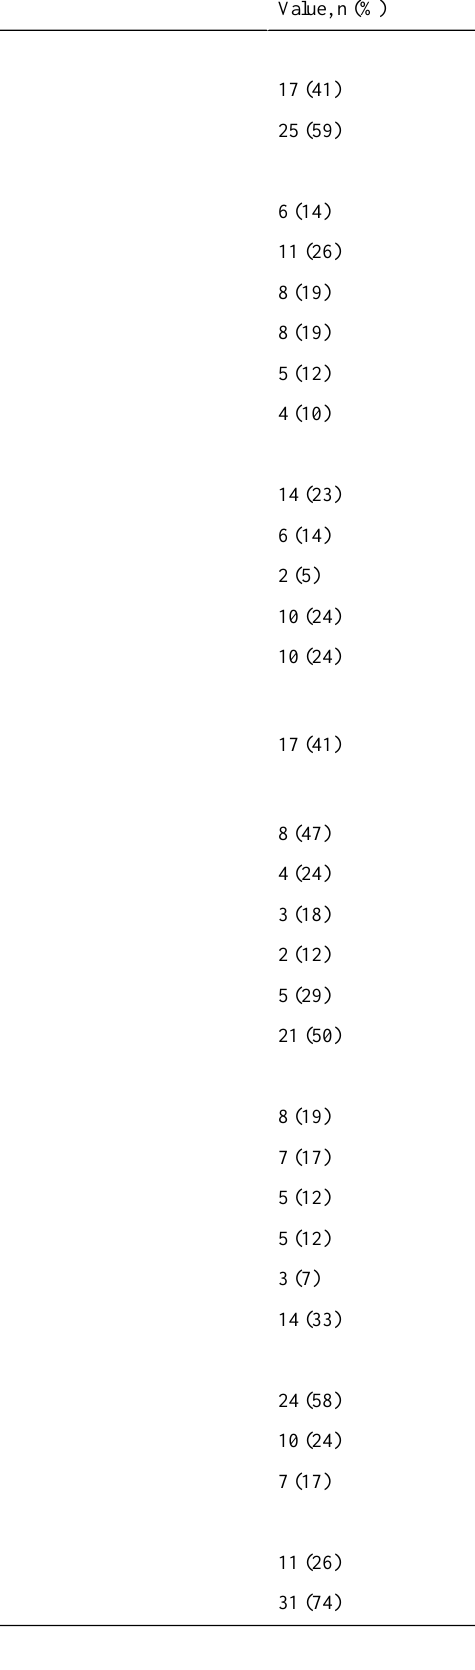
Table 1. Summary of participant characteristics